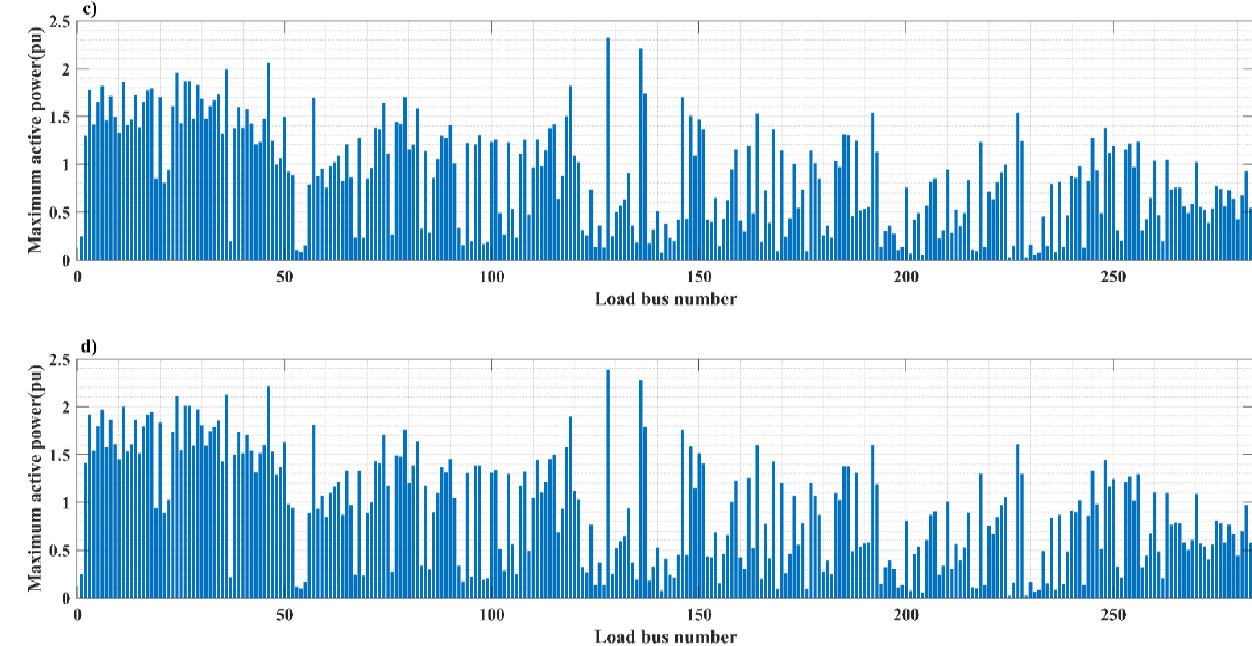
Table 3. Highest and lowest Pmax values under the four scenarios